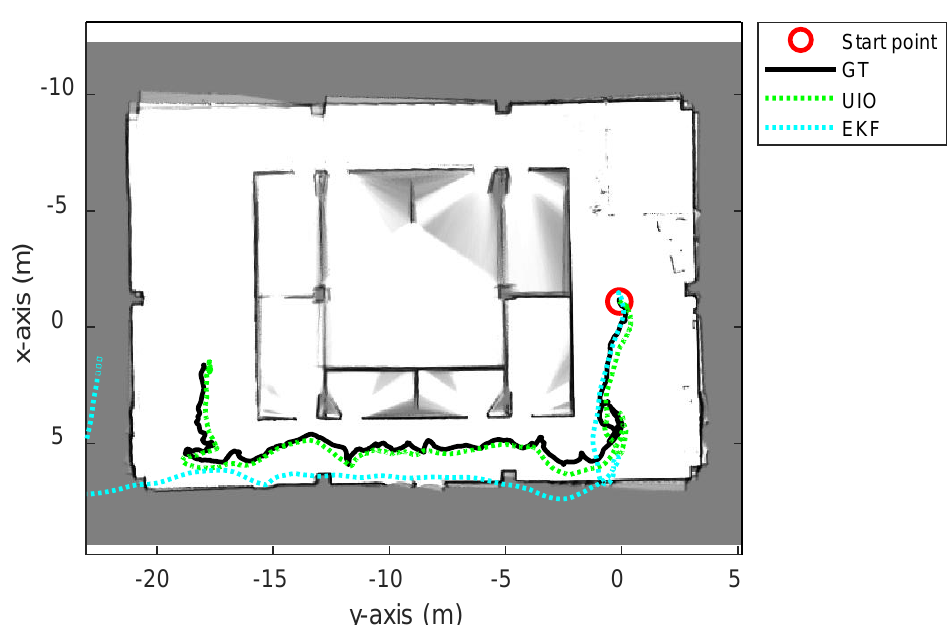
Figure 5. The overall trajectories estimated using the proposed UWB-Inertial odometry (UIO) and UWB-IMU tightly coupled EKF